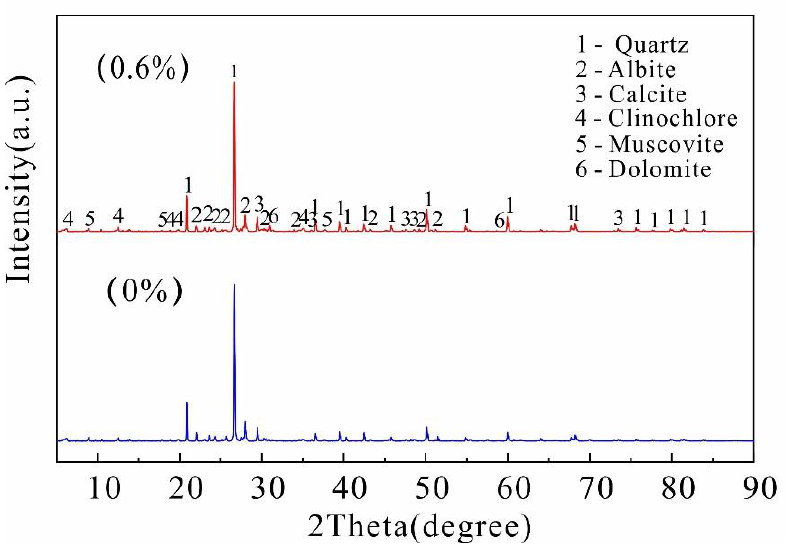
Figure 14. XRD diffraction pattern.